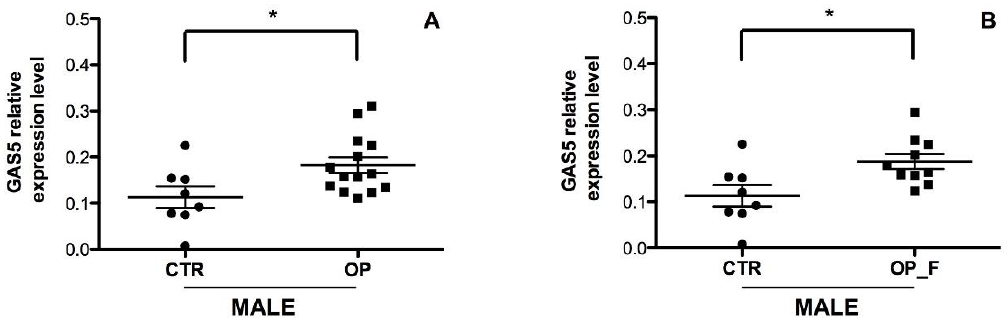
Figure 4. Serum expression level of GAS5 in OP male patients. ( A ) GAS5 expression level was analyzed in the serum of 14 OP total male, with and without fragility fractures, and 8 healthy male controls. * p < 0.05; ( B ) GAS5 expression level was analyzed in the serum of 10 OP fractured male and 8 healthy male controls. GAPDH mRNA level was used to normalize the relative amount of GAS5 and relative expression values are expressed as 2 −ΔCt . Individual data points represent the mean of duplicate assays for each sample. Statistical differences between groups were analyzed for significance using unpaired Student’s t-test. Error bars indicate mean ± s.e.m. * p < 0.05.